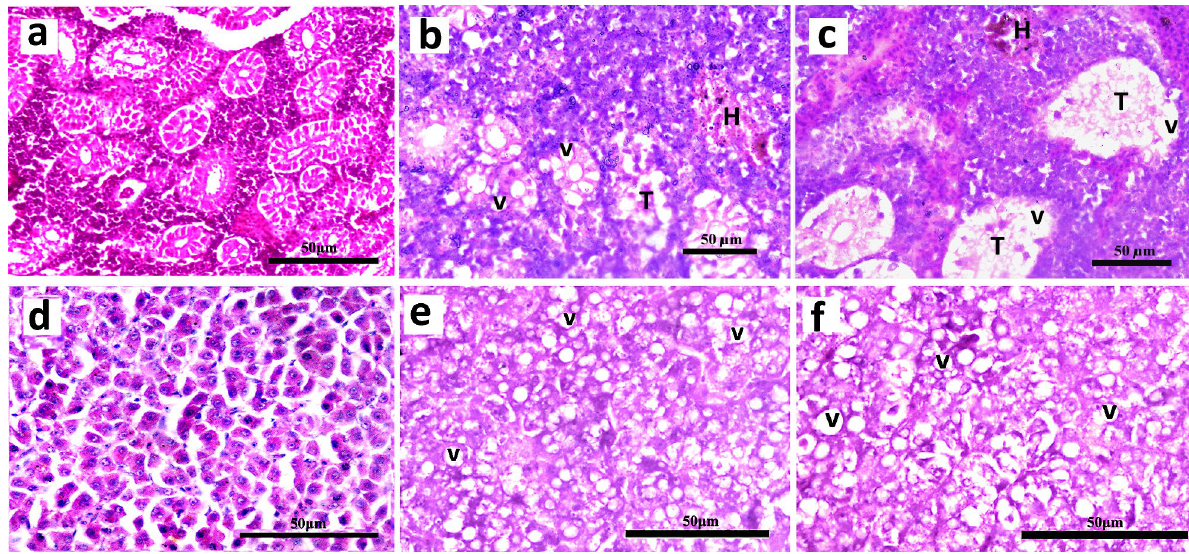
Figure 4. T. S. of ( a ) kidney and ( d ) liver in disease-free (as control) Anabas testudineus . T. S. of kidney of A. testudineus experimentally-challenged with ( b ) Aeromonas hydrophila and ( c ) A. jandaei [H, haemorrhage; T, vacuolar degeneration of renal tubules; V, vacuolation]. T. S. of liver experimentally-challenged with ( e ) A. hydrophila and ( f ) A. jandaei [V, vacuolation].